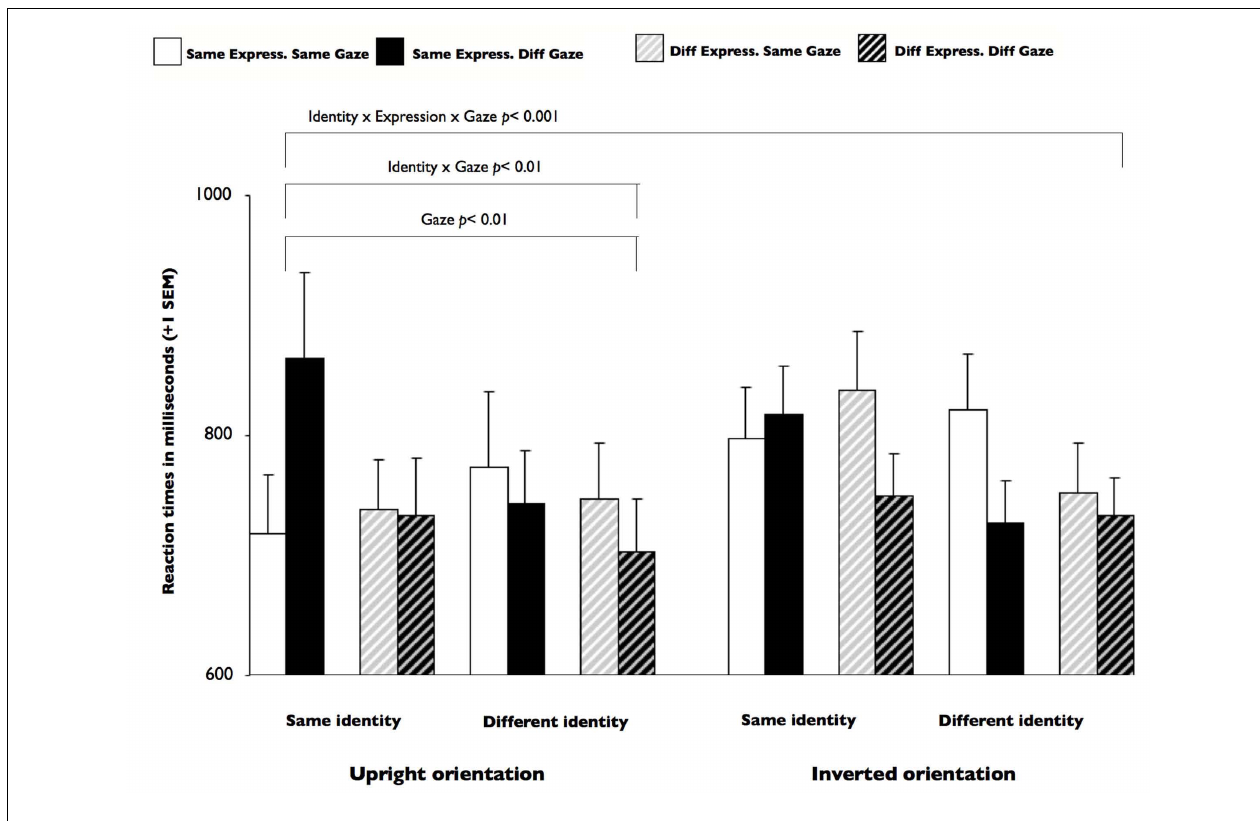
gaze, which was due to participants being slower to detect a change in gaze, when identity remained the same. For the inverted condition, no significant interaction between identity and gaze was observed.The simple main effects were significant for both identity and gaze, with participants being faster to detect a change in either feature. Diff, different; Express,